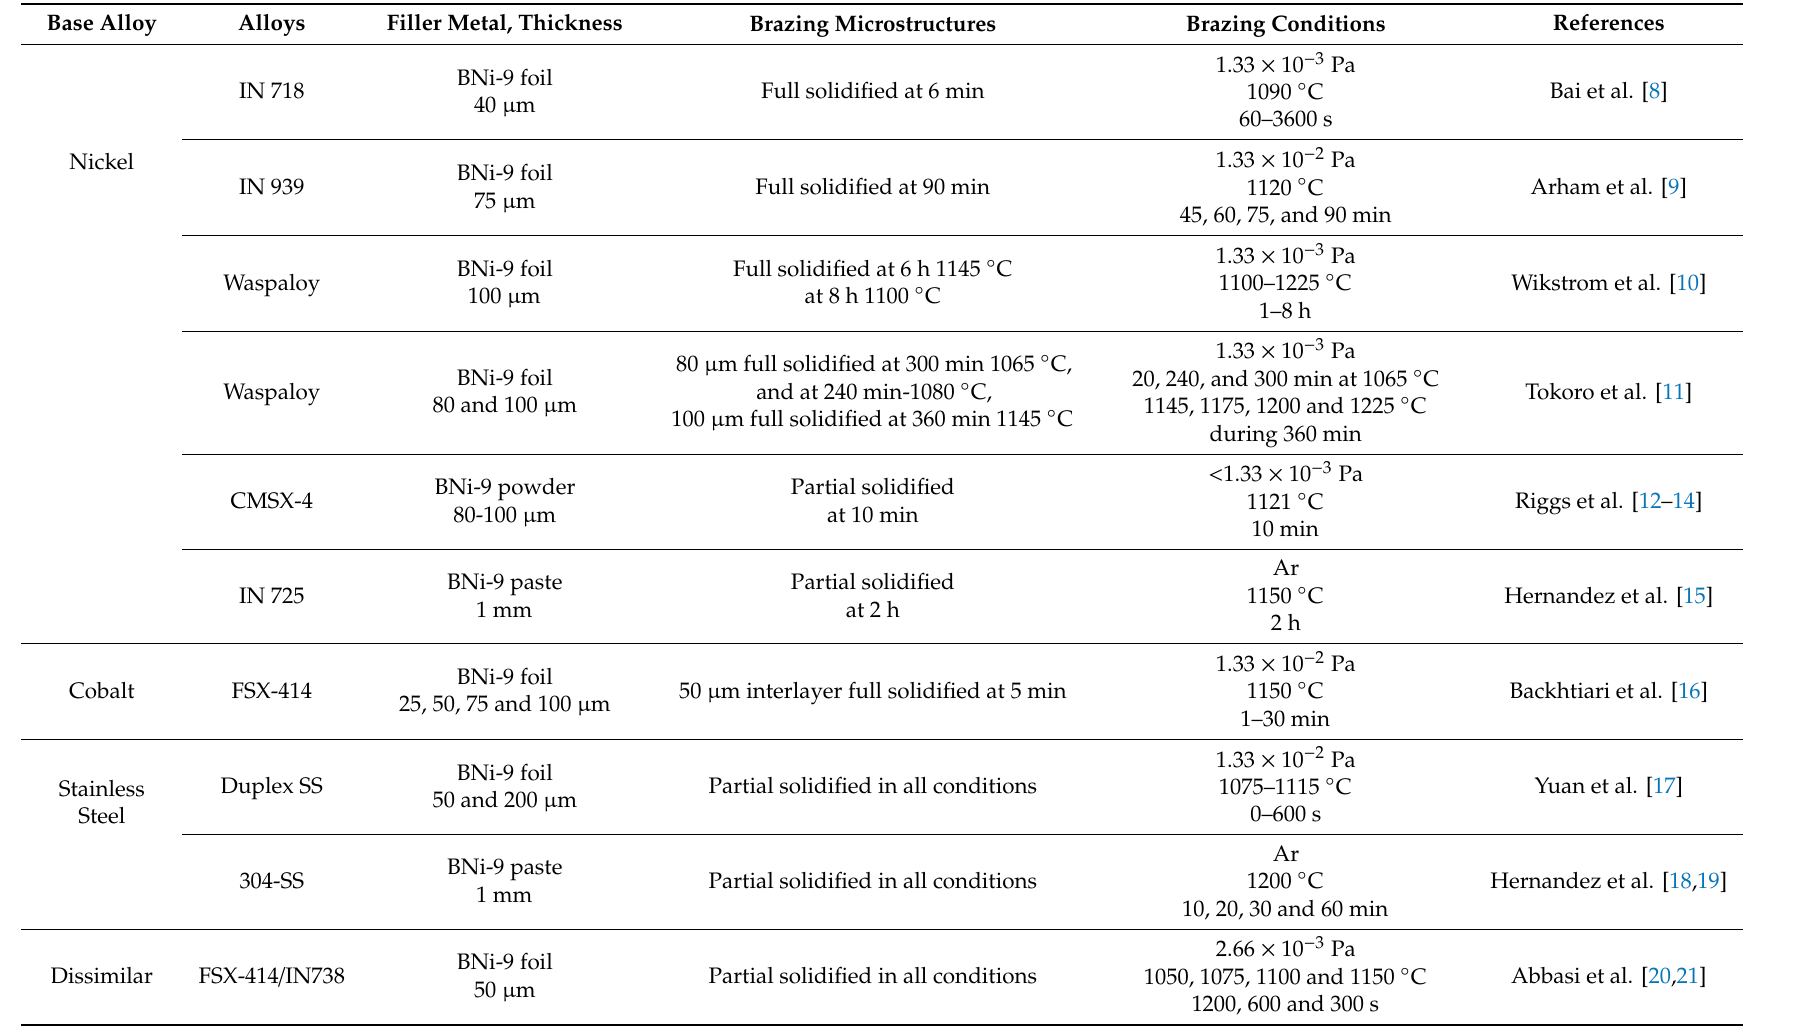
Table 1. Experimental conditions of some studies performed using